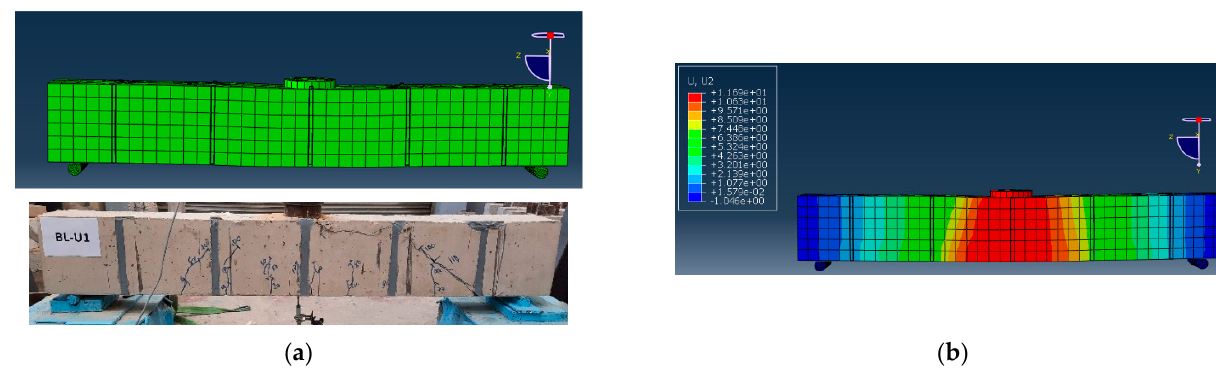
Figure 16. ( a ) Experimental and FEA deflected shape and ( b ) deflection values.